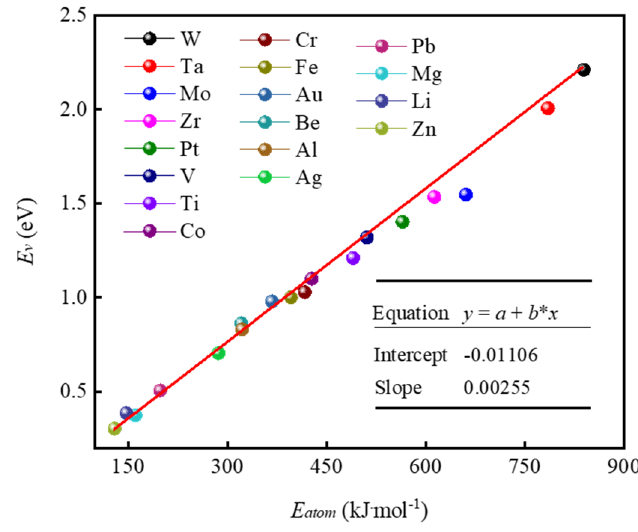
Figure 6. Relationship between vacancy formation energy and chemical bonding energy of common metals. (The red line in the graph shows the fitted trend line, and detailed data can be found in the Supplementary Materials Table S15.)